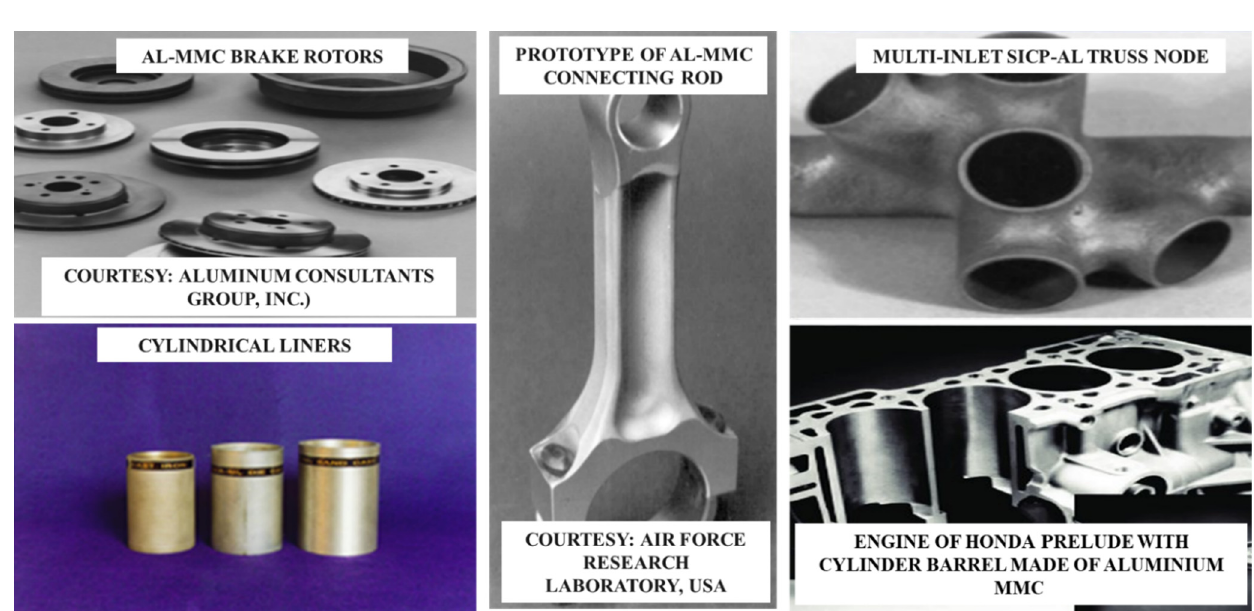
Figure 2. Applications of Al-based MMCs in automotive industry